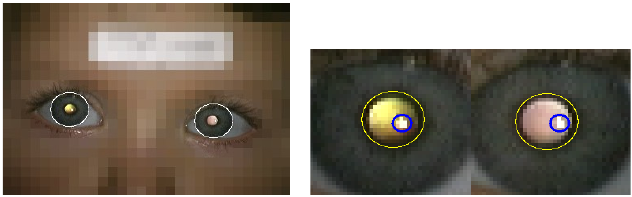
Figure 1. Key frame output from the AVVDA system